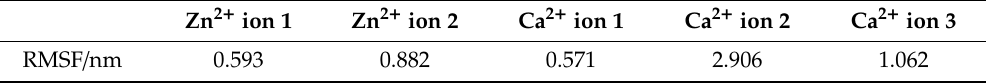
Table 4. Solvation properties of the associated divalent cations. SASA, solvent exposed surface area.